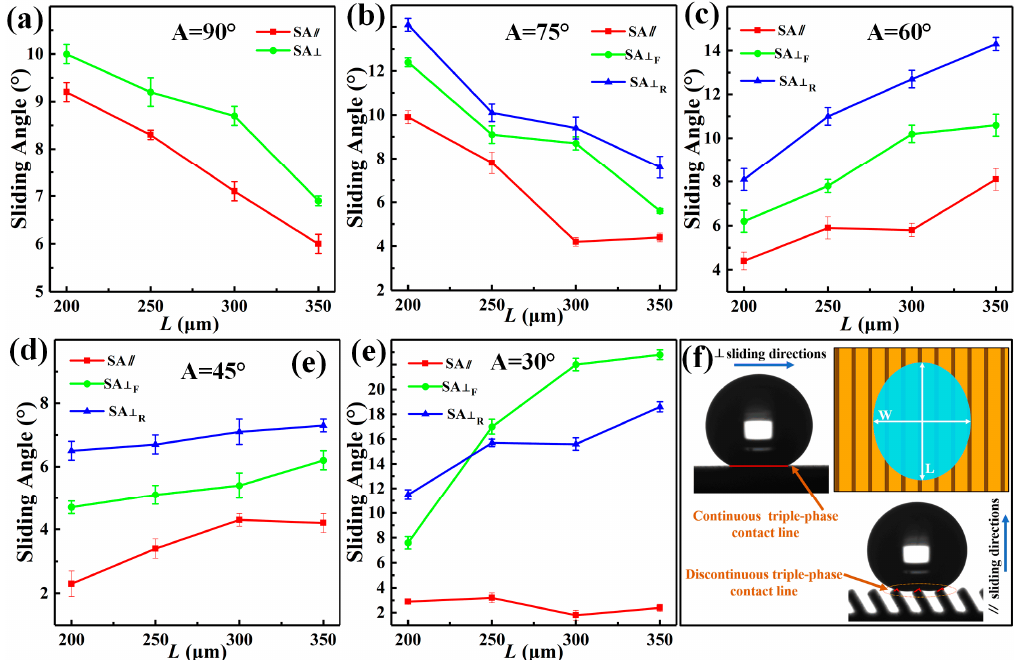
Figure 9. Schematic diagram of the change of the sliding direction on the groove surfaces with different inclination angles with L and the anisotropic wetting: the angle of the inclined groove ( a ) A = 90°; ( b ) A = 75°; ( c ) A = 60°; ( d ) A = 45°; ( e ) A = 30°; ( f ) Schematic diagram of anisotropic wetting.